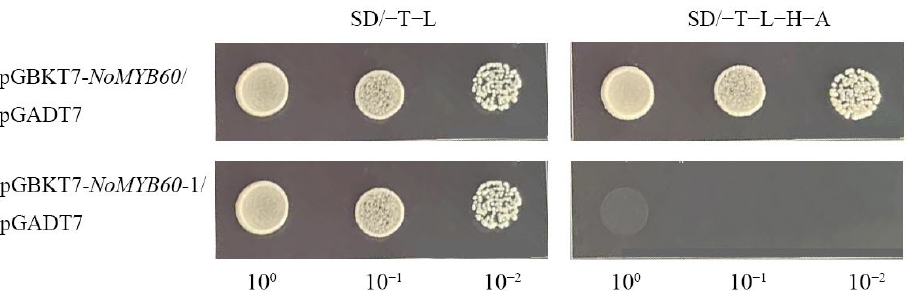
Figure 7. Transcriptional activation activity analysis of NoMYB60. Transcription activity assay of NoMYB60 in yeast. NoMYB60 and NoMYB60-1 represent the full-length protein, as well as the regions encoding 1–277 amino acids of NoMYB60, respectively, which were inserted into the pGBKT7 vector. In the Y2H assay, we discovered that co ‐ transformation containing the PGADT7 ‐ No ‐ BEH1/2 and pGBKT7 ‐ NoMYB60 ‐ 1 plasmids could grow on both SD/ − T − L and SD/ − T − L − H − A media. This result indicates that NoMYB60 may physically interact with NoBEH1/2 (Figure 8). Figure 8. Yeast two ‐ hybrid analysis of interaction between NoMYB60 and NoBEH1/2. The verifica ‐ tion of the interaction between NoMYB60 ‐ 1 and NoBEH1/2 by Y2H assay. The yeast cells were grown on the SD media: SD/ − T − L (left), SD/ − T − L − H − A (right). pGBKT7 ‐ 53/pGADT7 were used as the positive control. 10 0 , 10 − 1 and 10 − 2 represent the concentrations of yeast solutions. 3.8. Verification of the Interaction between NoMYB60 and NoBEH1/2 by BiFC The binding relationship between NoMYB60 and potential interacting proteins was further analyzed by BiFC assay. No yellow fluorescence signal was found in tobacco leaf epidermal cells co ‐ transformed with NoMYB60 ‐ cYFP and empty vector nYFP, while sig ‐